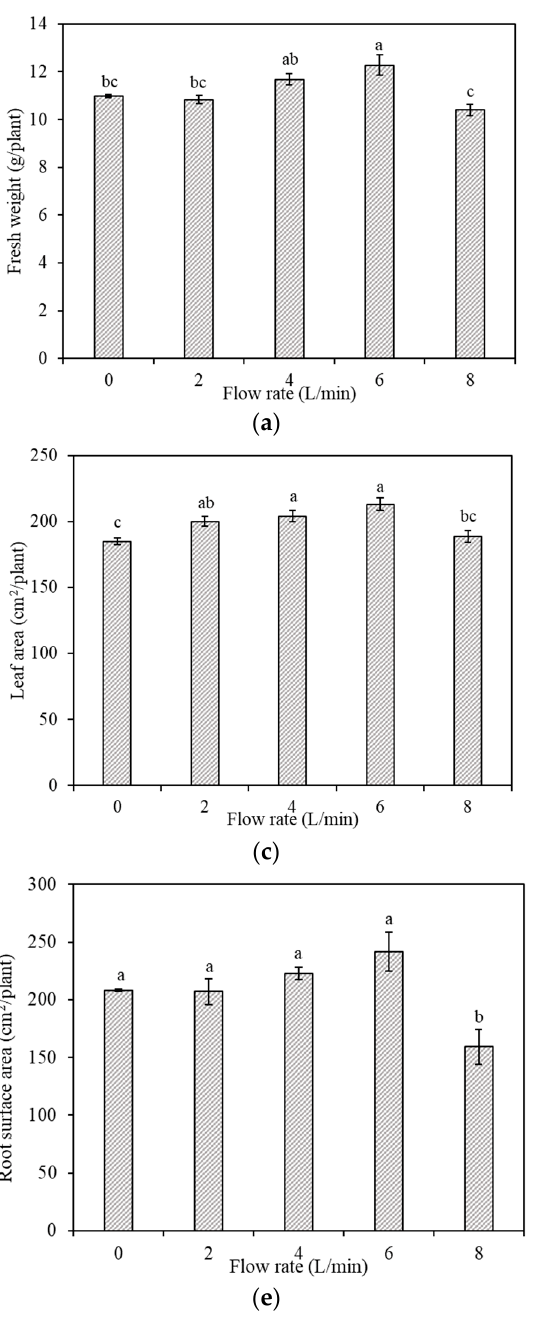
Figure 4. Plant growth, root morphology, and nutrient uptake under different flow rates. ( a ) Fresh weight; ( b ) dry weight; ( c ) leaf area; ( d ) root length; ( e ) root surface area; ( f ) N uptake by a plant. Bars labelled with different letters differ significantly ( p < 0.05), data are expressed as M.S.E ( n =